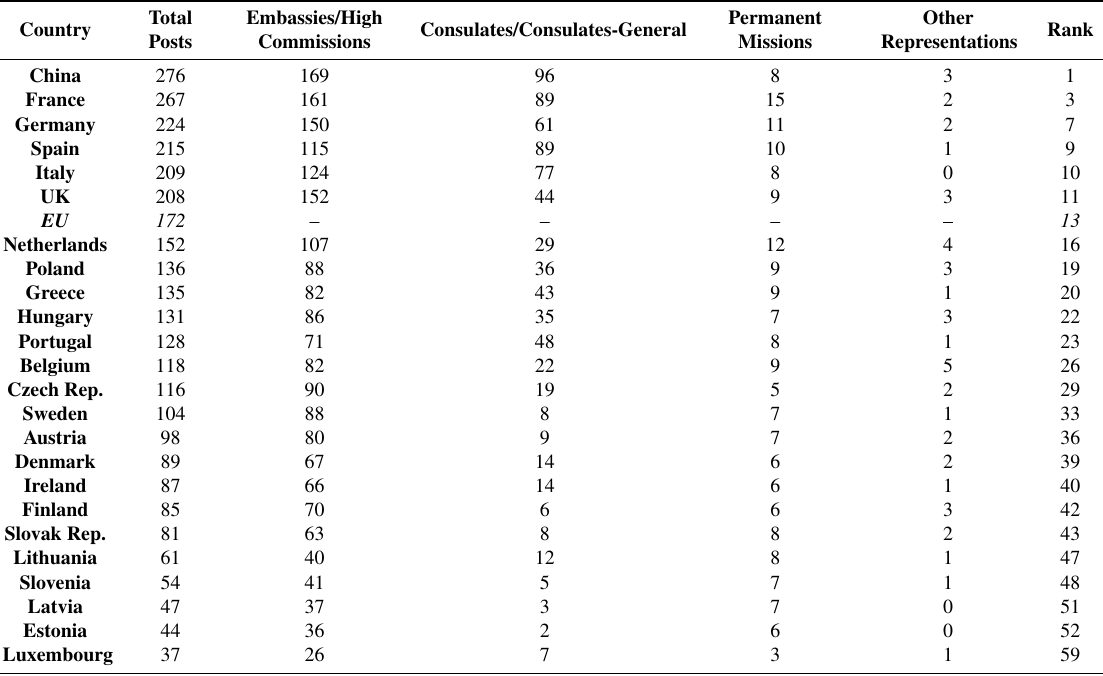
Modified Global Diplomacy Index,